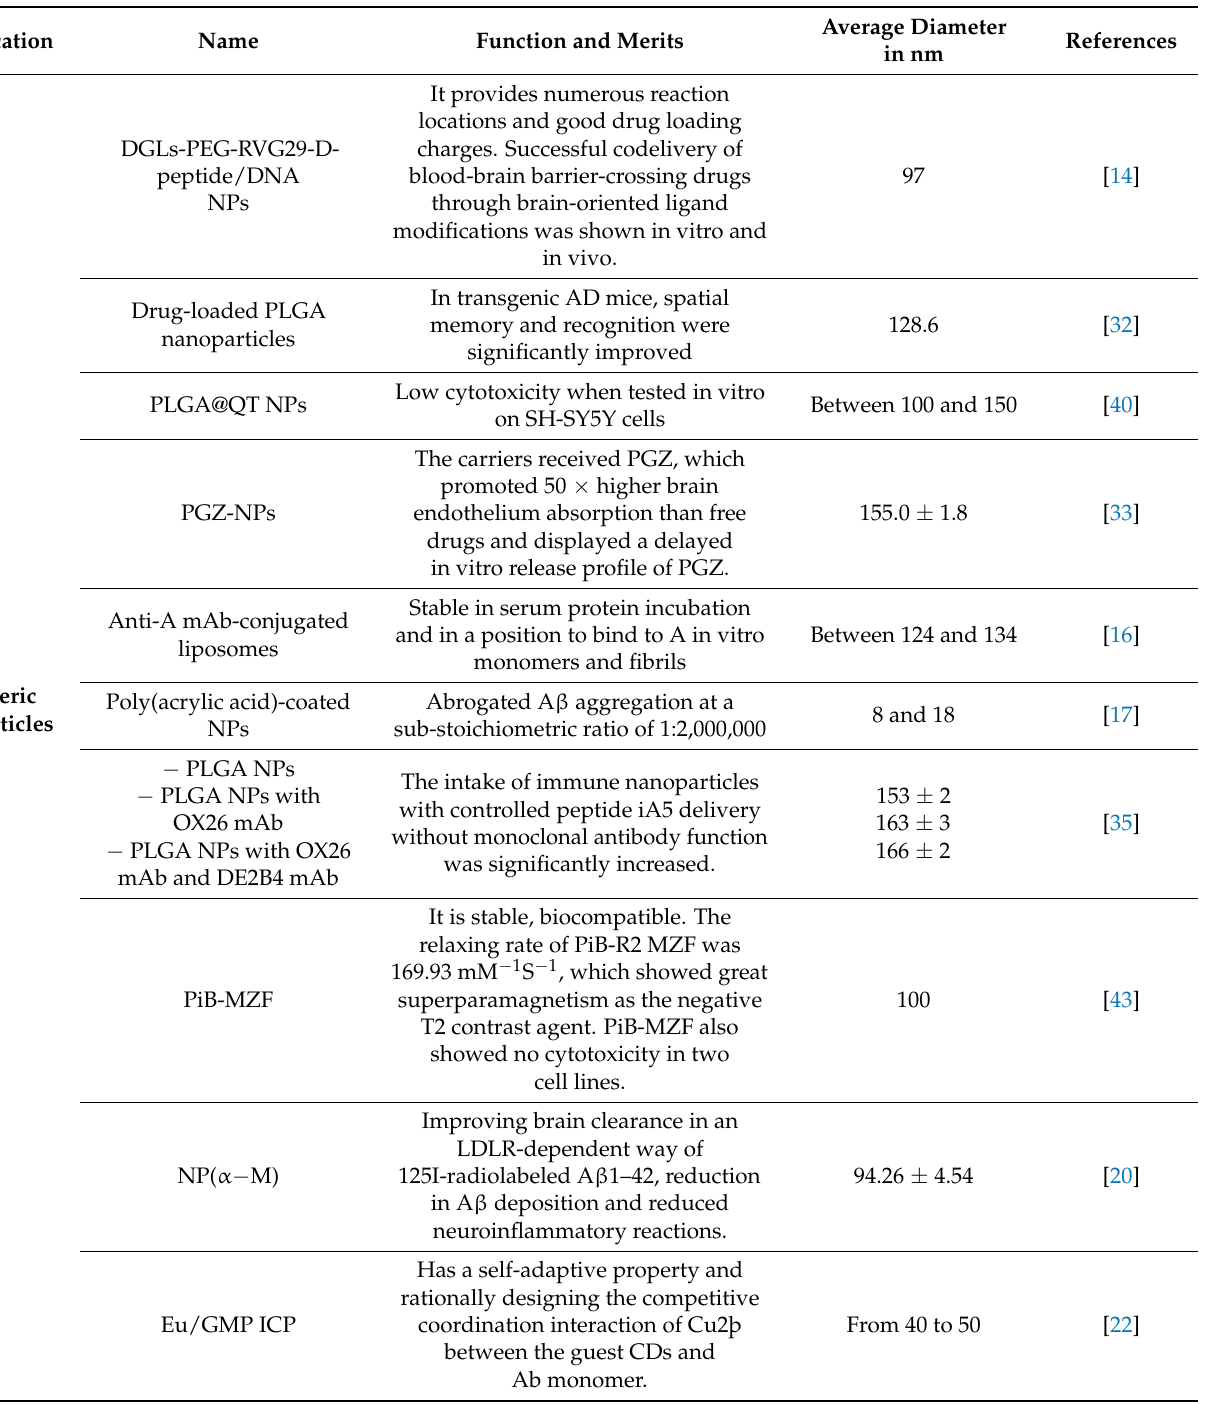
Table 1. Comparison between different types of nanoparticles used in Alzheimer’s disease treatment.